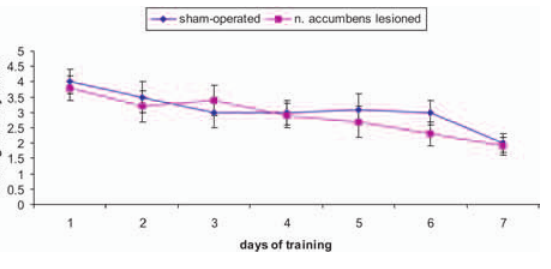
Figure 2. The number of working memory errors in the rats with 6-OHDA-induced lesion of the NAcc, as studied in the radial-arm-maze task. The values are mean ± SEM (n=6 animals per group).